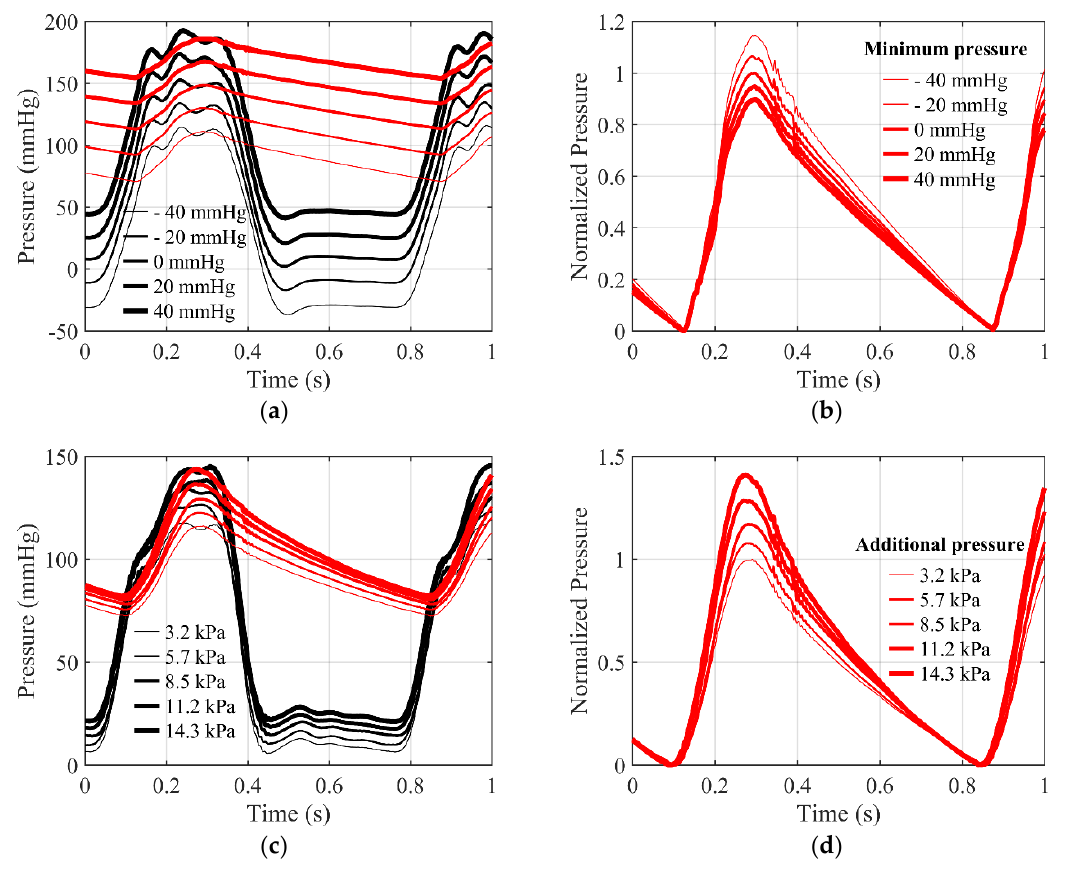
Figure 10. Experiment result according to aortic compliance: ( a ) measured pressure waveforms according to minimum pressure of the reservoir method, : ventricular pressure, : aortic pressure; ( b ) normalized aortic pressure waveform according to minimum pressure of the reservoir method; ( c ) measured pressure waveforms according to additional pressure of the new compliance chamber, : ventricular pressure, : aortic pressure; ( d ) normalized aortic pressure waveform according to additional pressure of the new compliance chamber.